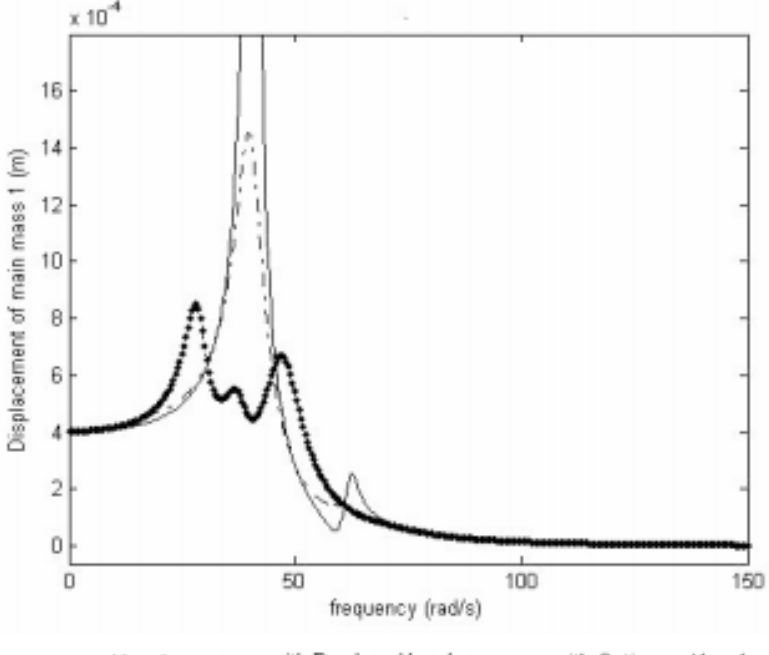
Fig. 7. Displacement of main mass